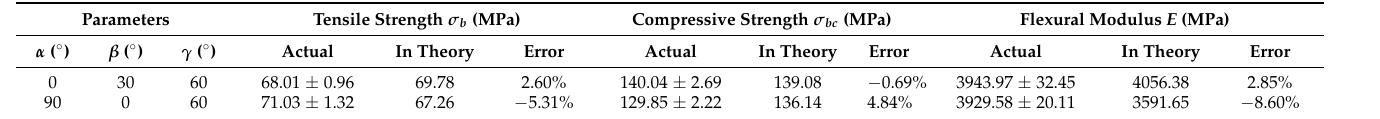
Table 4. Comparisons of prediction values with actual